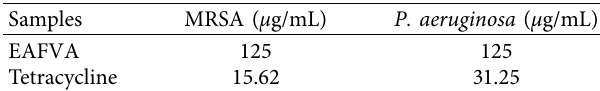
Table 1: Te ratio of fow rate and mobile phase. Table 2: Minimum inhibitory concentration of EAFVA against MRSA and P. aeruginosa